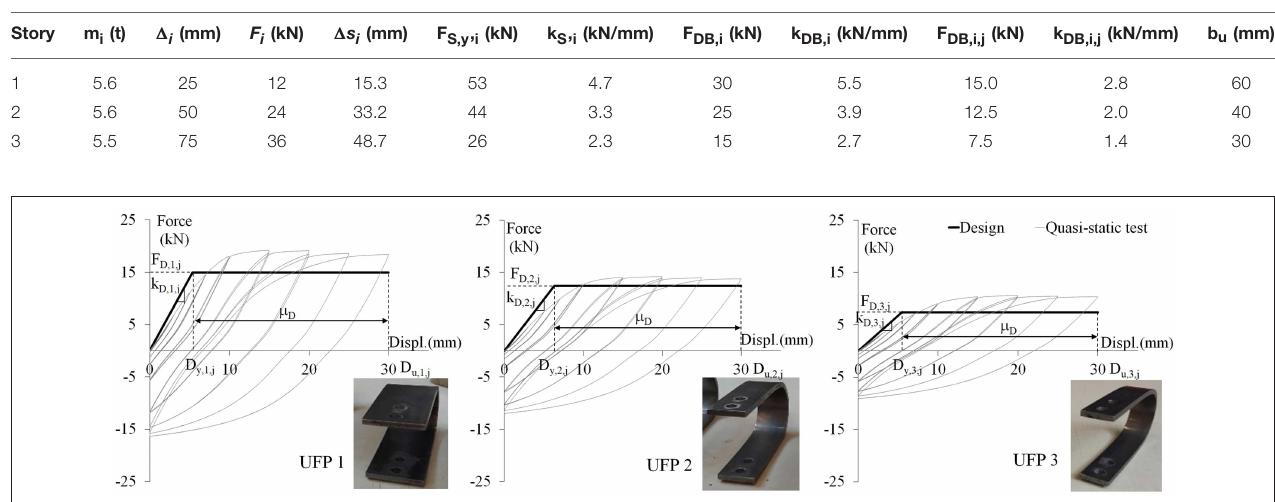
TABLE 2A | Characteristics of the braced post-tensioned frame.